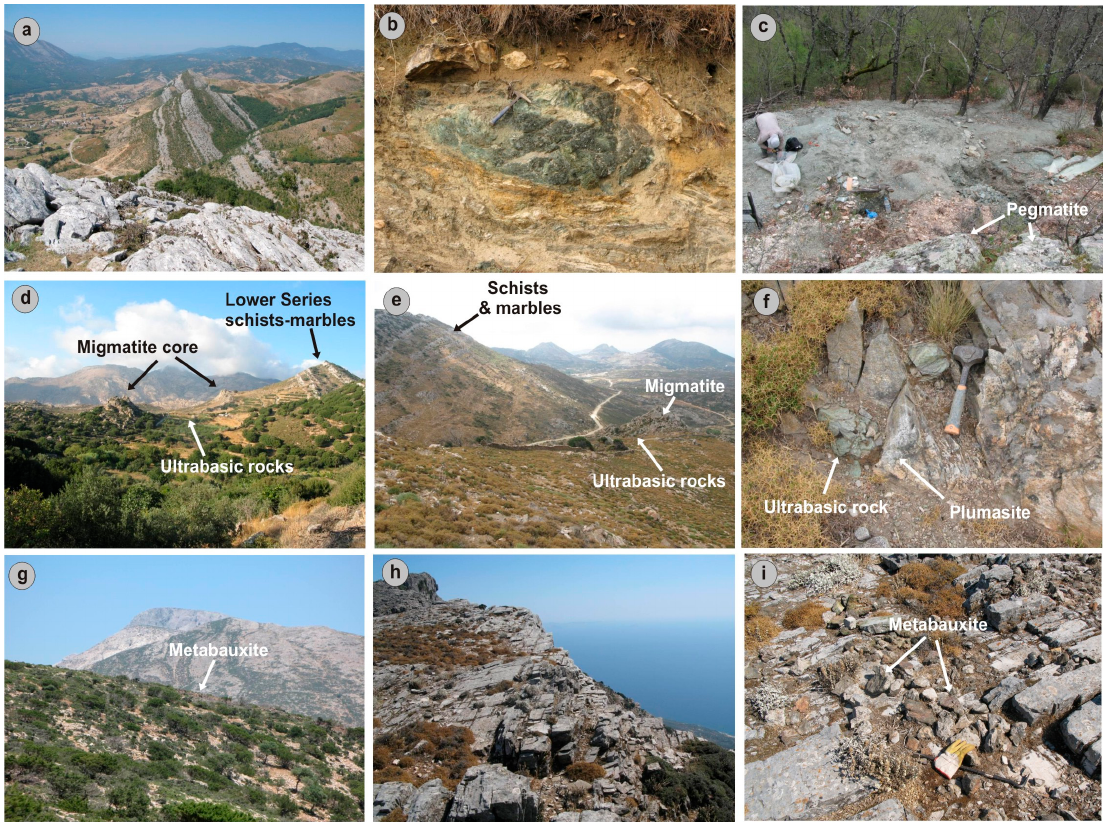
Figure 2. Field photographs demonstrating the geological setting of the ruby and sapphire occurrences in Greece. ( a ) Marble layers alternating with eclogitic amphibolites at Gorgona/Xanthi; ( b ) Boudinaged hornblende schists, intercalated within eclogitic amphibolites, marbles and metapegmatites at Paranesti/Drama; ( c ) The main ruby working at Paranesti. The pegmatite body at the lower part of the photograph shows no desilification; ( d , e ) Ultrabasic rocks between the migmatite dome-like core and the overlying kyanite-sillimanite grade schists and marbles in the two plumasite localities east of Kinidaros, Naxos island; ( f ) Corundum-bearing plumasite at the contact to ultrabasites at the locality shown in Figure 2e; ( g ) Panoramic view of the metabauxite bearing marbles at Kavalaris Hill, southern Naxos island; ( h ) Panoramic view for the metabauxite-bearing marbles of Ikaria unit; ( i ) Corundum-bearing metabauxite lenses within the Ikaria unit marbles.